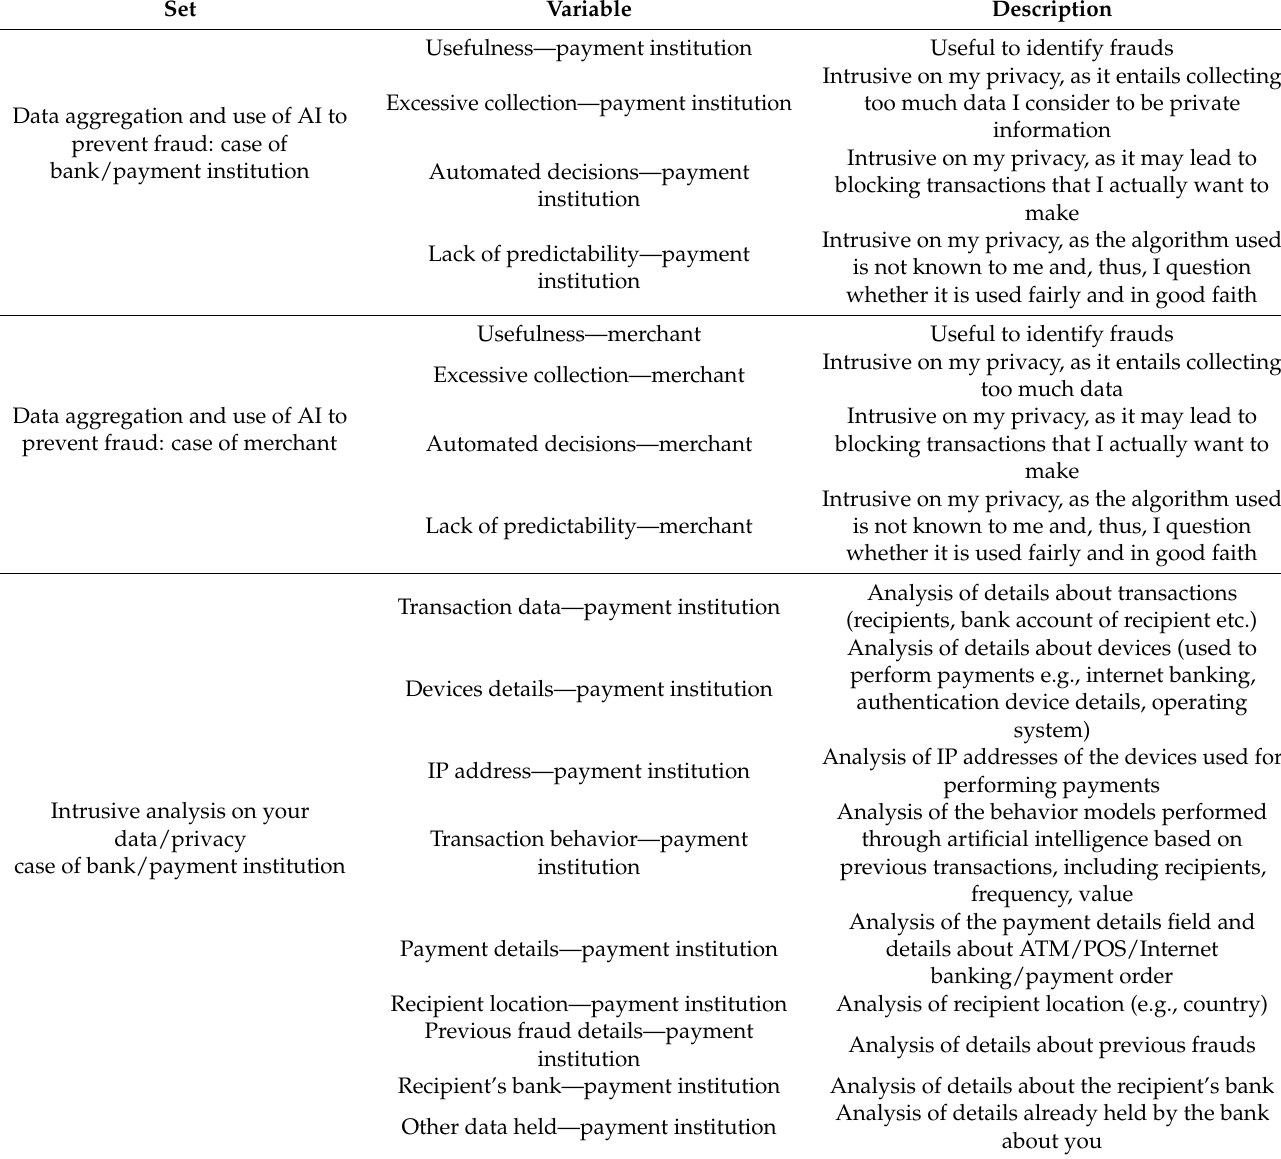
Table 2. Variables’